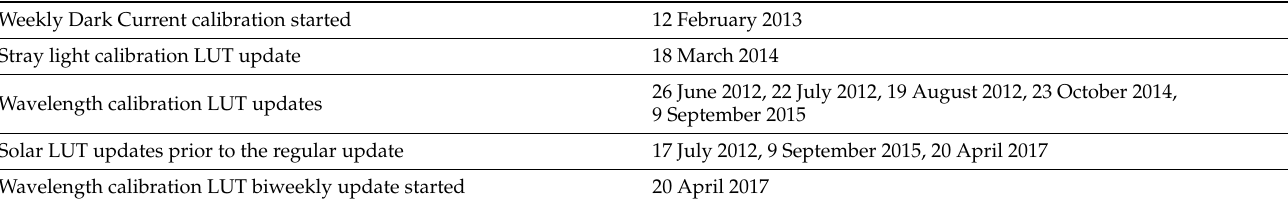
Table A1. Timeline for the S-NPP/OMPS/NP calibration LUTs updates.